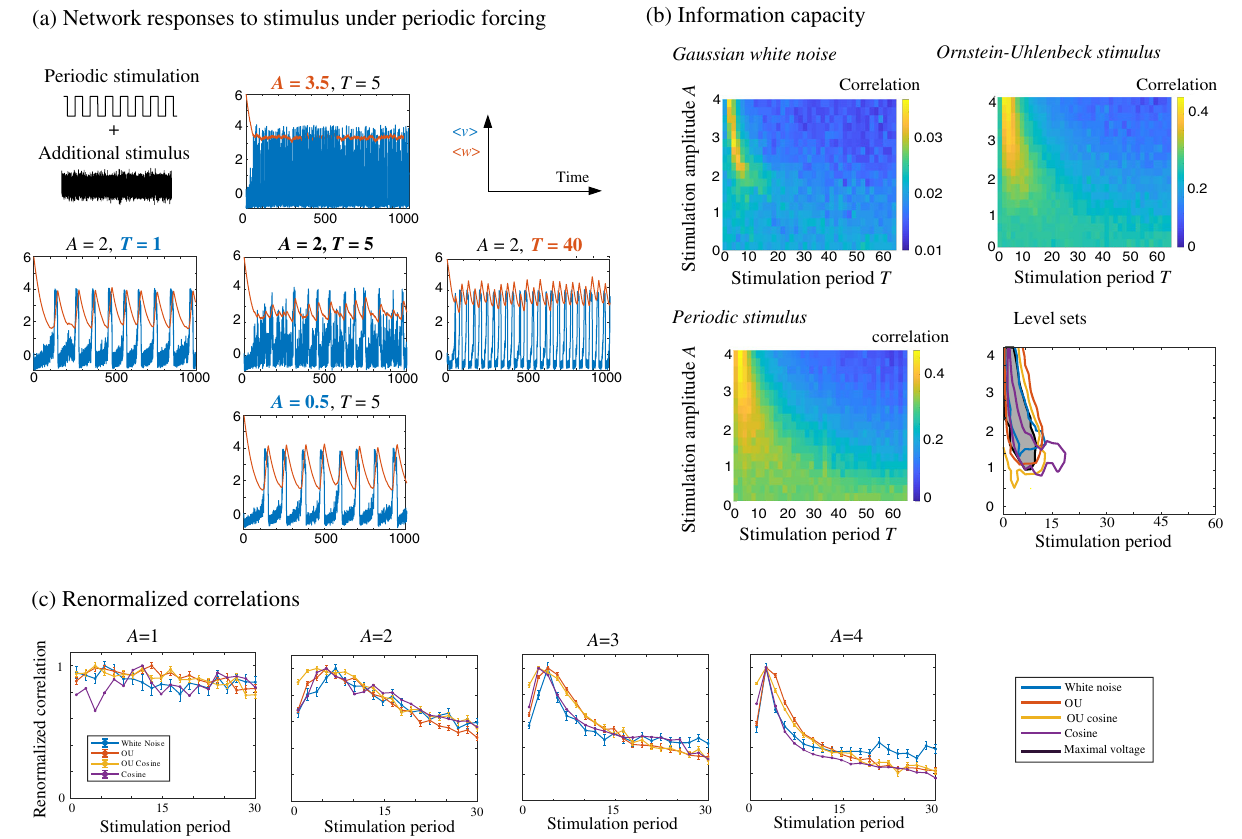
FIG. 7. Information transmission of the Fitzhugh-Nagumo network model evaluated by Pearson ’ s correlations between stimulus and network response. Parameters as in Fig. 6(a) (oscillations-induced desynchronization, with n ¼ 4000 neurons). (a) Trajectories of mean network activity in response to Gaussian white noise, as a function of DBS parameters (amplitude and frequency). (b) Pearson ’ s correlation coefficient between average voltage and input for various values of the amplitude A and period T of DBS for Gaussian white noise input (upper left), stationary Ornstein-Uhlenbeck (OU) process (upper right), and Ornstein Uhlenbeck process centered at a sine wave (lower left). Lower right-hand panel shows a level set for each of these maps (blue, white noise; red, Ornstein-Uhlenbeck; yellow, Ornstein-Uhlenbeck centered at a sine wave; purple, pure cosine) compared with the level set associated with maximal voltage amplitude, identifying the loss of spontaneous oscillations in Fig. 5(b). (c) Rescaled Pearson ’ s coefficient as a function of DBS period for 4 values of the input amplitude, as a function of DBS period, show nicely overlapping profiles indicating consistent improvement of the information process for all types of stimuli depending on